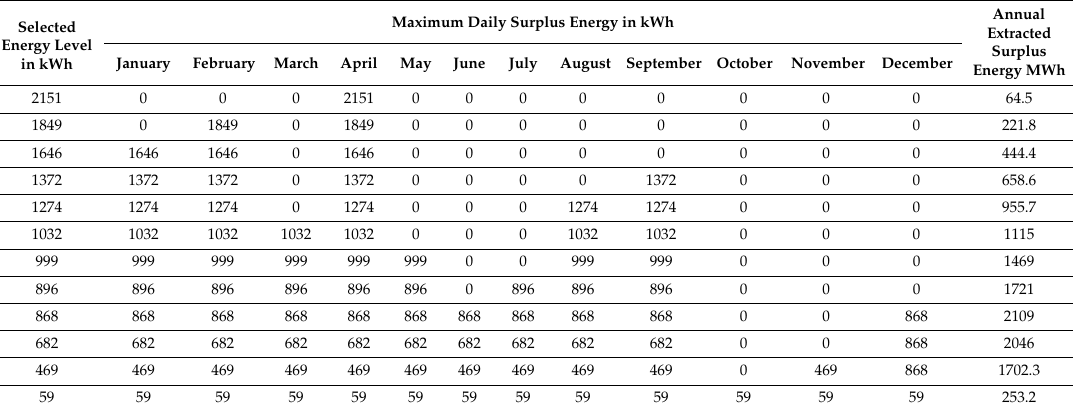
Table 3. Available daily surplus energy at various CSS capacities.